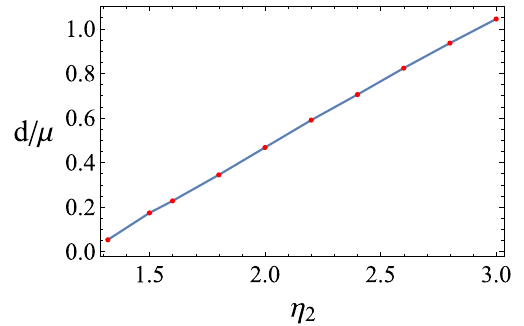
Fig. 6 The relation between η 2 and the width of the gap d /μ for fixed α = 5 and T = 0 . 01